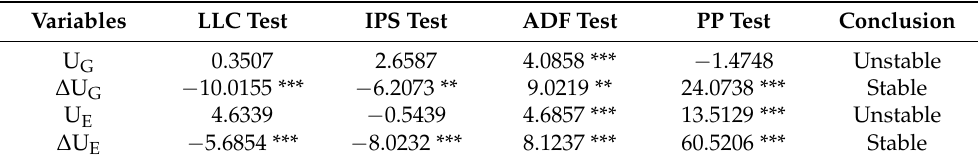
Table 4. Results of Unit Root